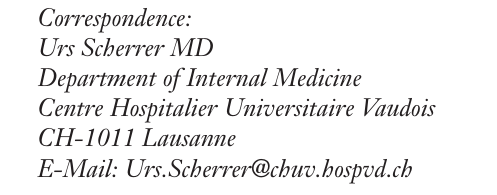
Plasma glucose concentration during intraperitoneal glucose tolerance tests (IPGTT). Results are mean ± SEM for at least 7 mice in each